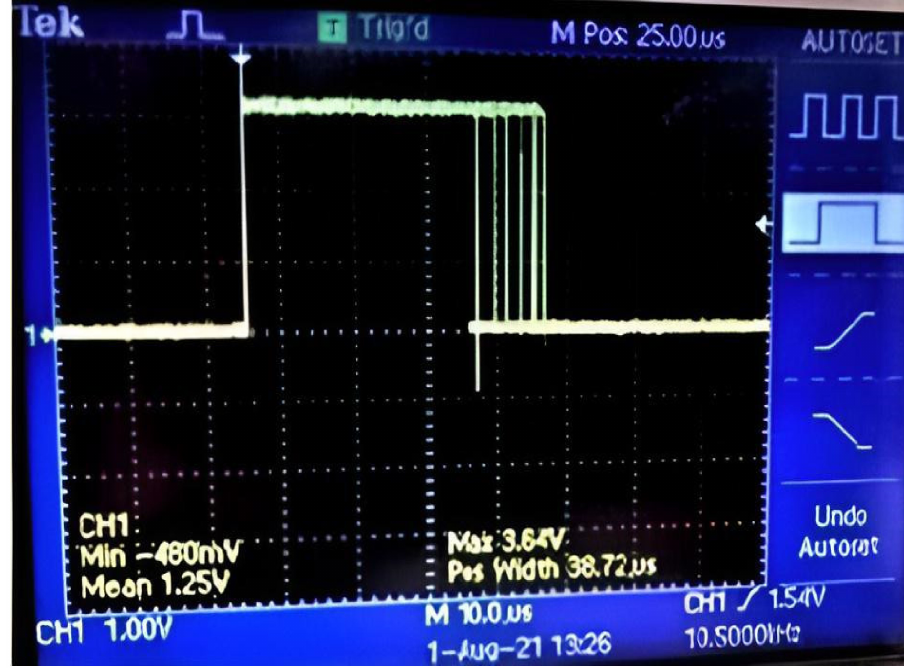
Figure 19. Change in the duty cycle in pulses input for inverter.